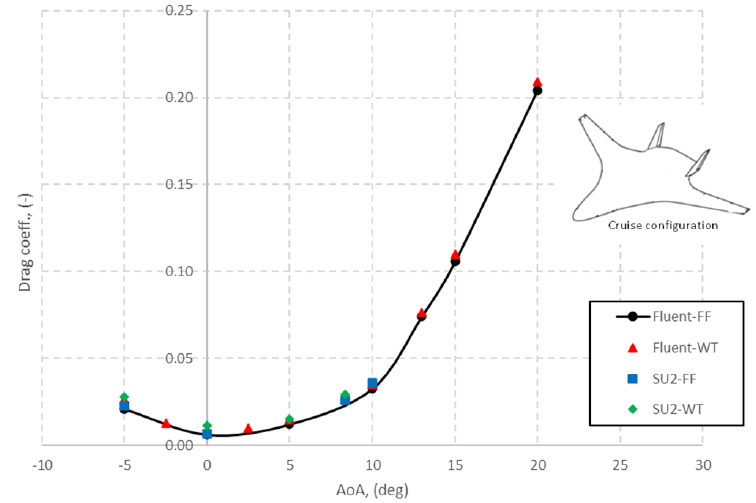
Figure 21. Drag coefficients versus AoA, effect of the Reynolds number.